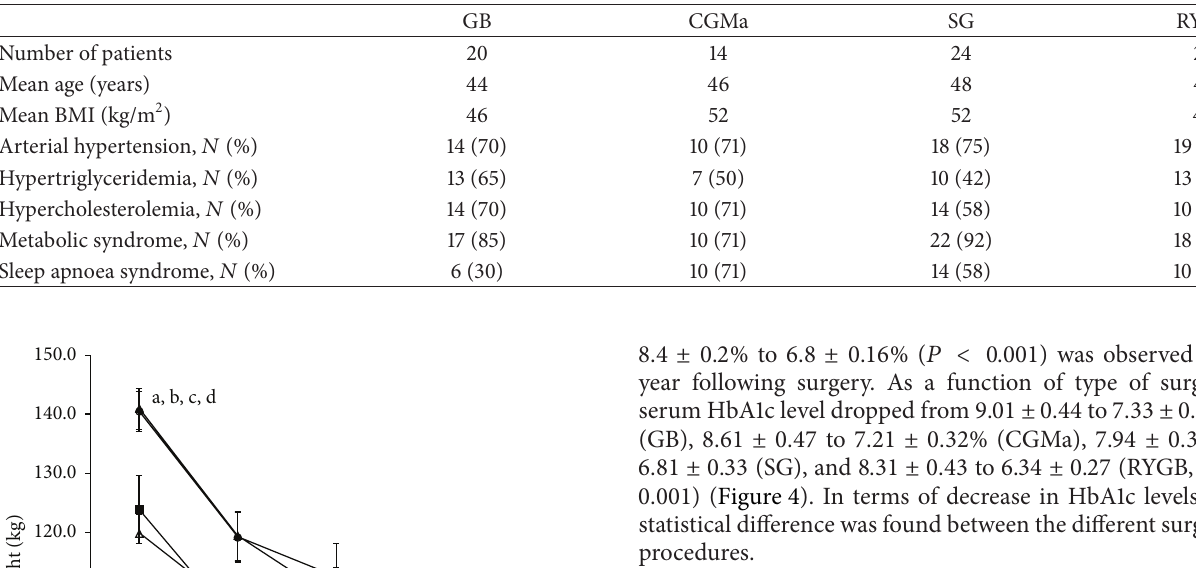
Table 1: Baseline characteristics of the obese patients with type 2 diabetes.